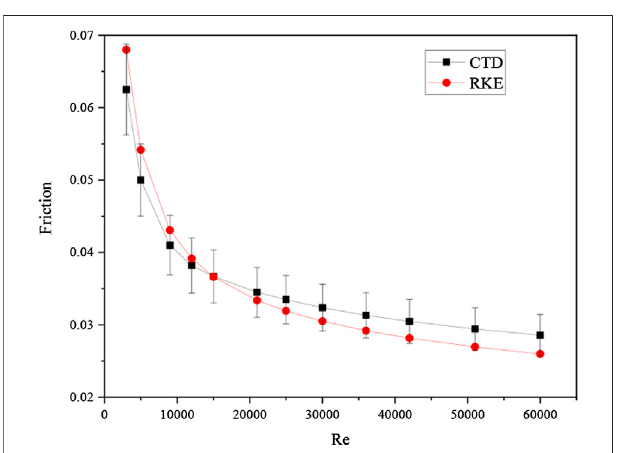
FIGURE 9 | Comparison of the friction factor.